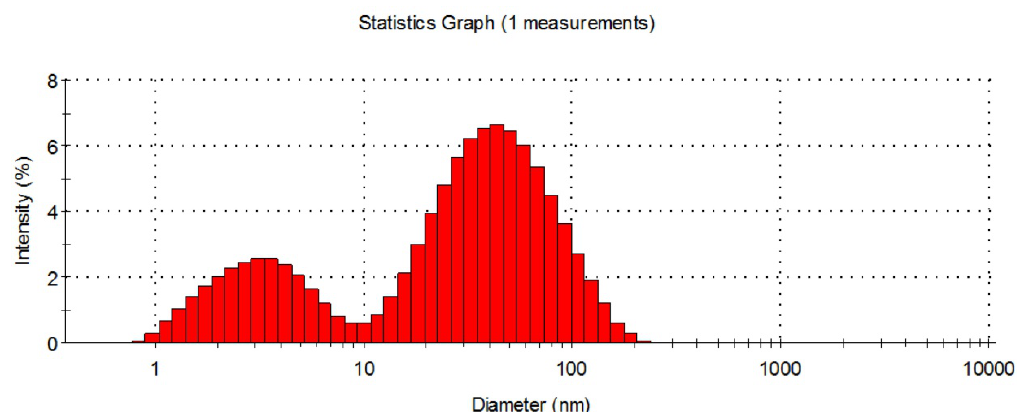
Figure 1 : Distribution of particles by size in the 15 nm nano-silver solution. (Before beginning our study, in vitro tests performed at the Turkish Centre for Disease Control revealed that nano-silver (used in our study) produced at the Istanbul Technical University Faculty of Metallurgy was effective against Escherichia coli (ATCC 259922), Staphylococcus aureus (ATCC 25923), and Salmonella spp. (RS) with no bacterial growth in the